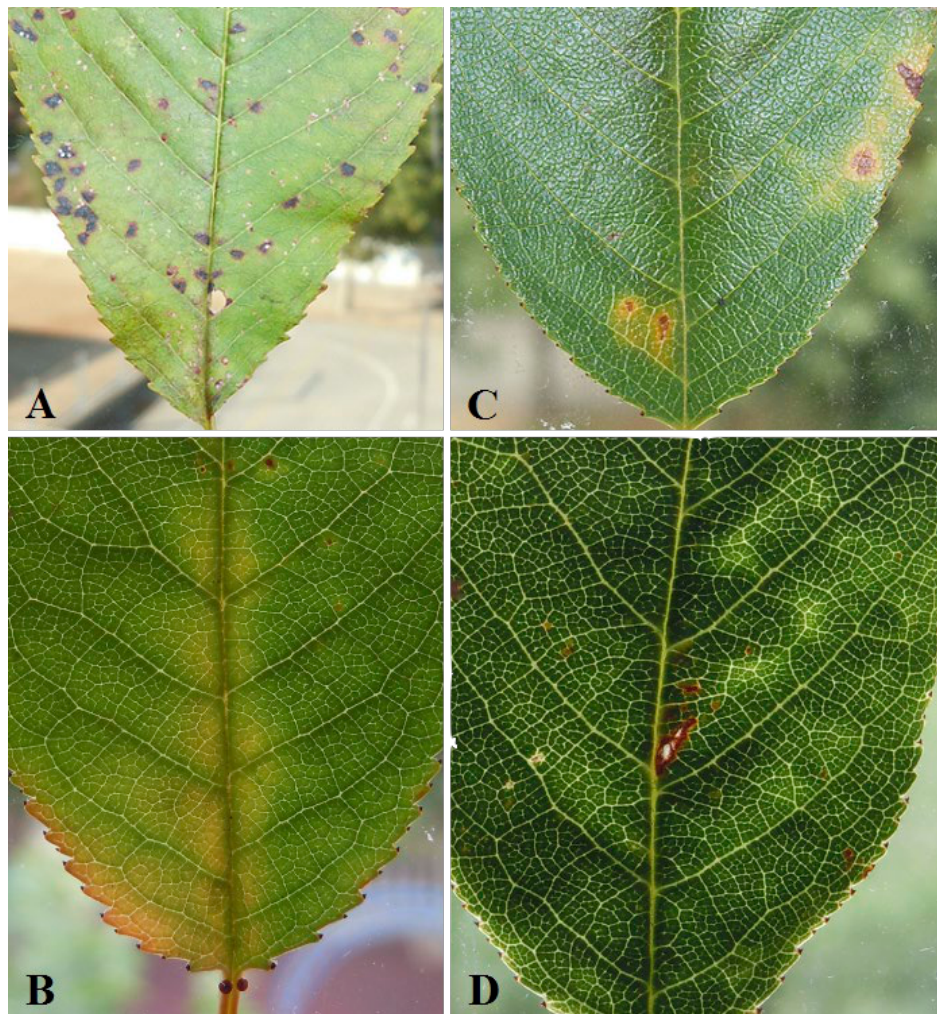
Figure 1. Leaf symptoms associated with single or mixed viral infections; (A) chlorotic and dark-brown necrotic ringspots induced by PNRSV; (B) generalized chlorosis around the midvein due to PDV; (C) chlorotic and reddish necrotic ringspots induced by ACLSV; (D) generalized interveinal chlorosis due to PNRSV-PDV mixed